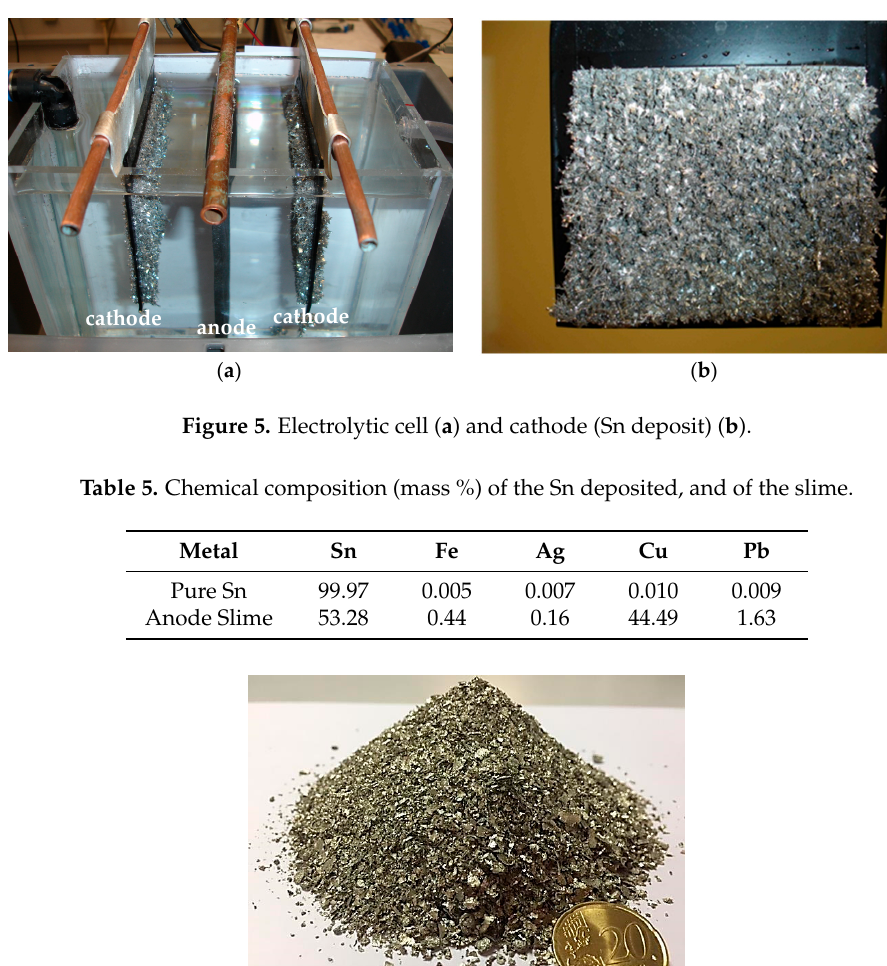
Figure 6. Highly pure Sn obtained by electrorefining.